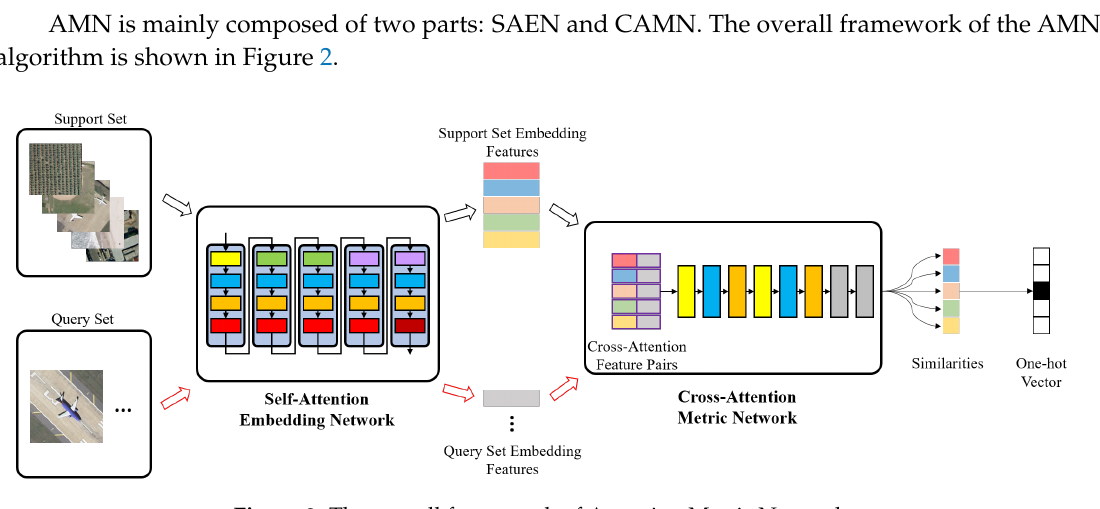
Figure 2. The overall framework of Attention Metric